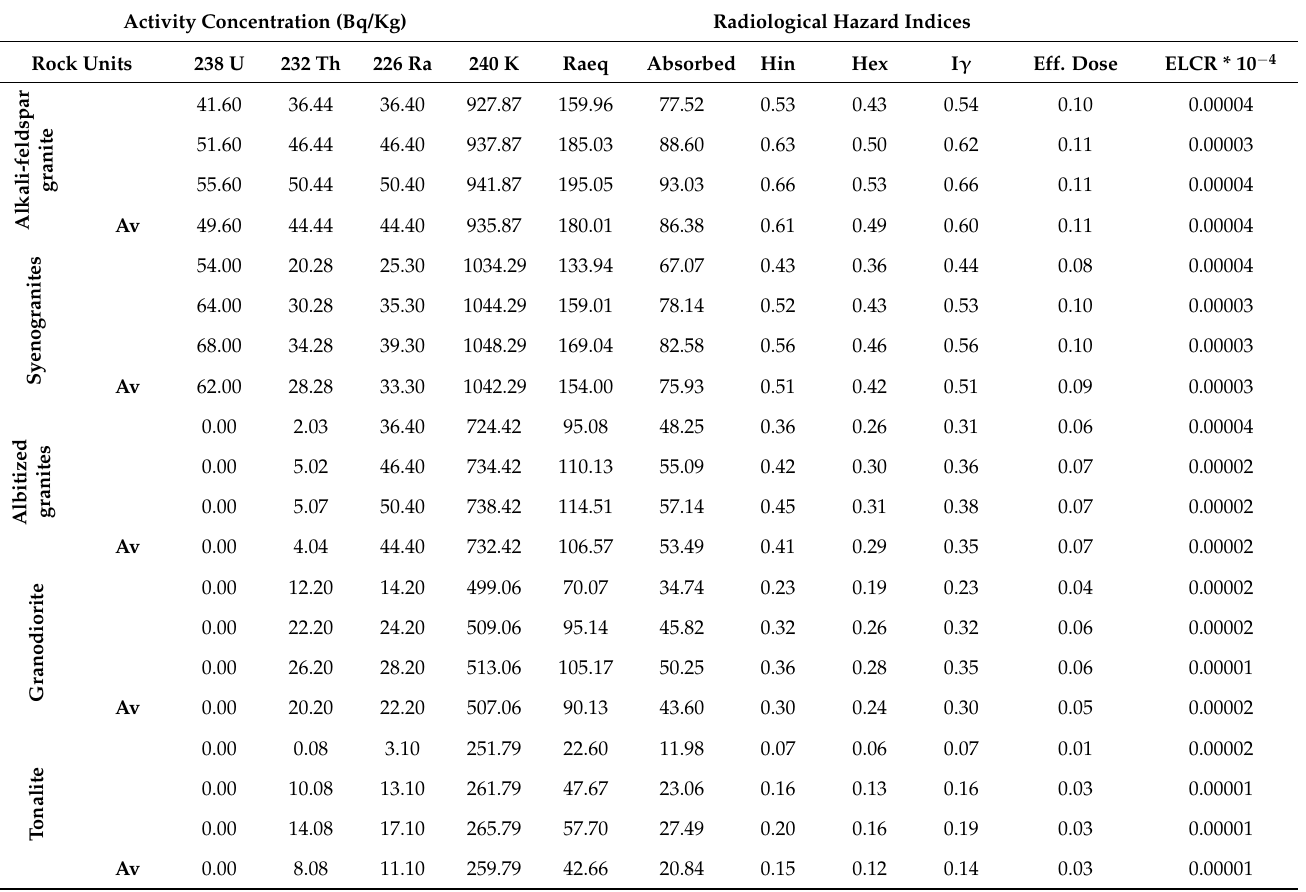
Table 2. The measured activity concentrations for radionuclides and radiological hazard indices for the examined